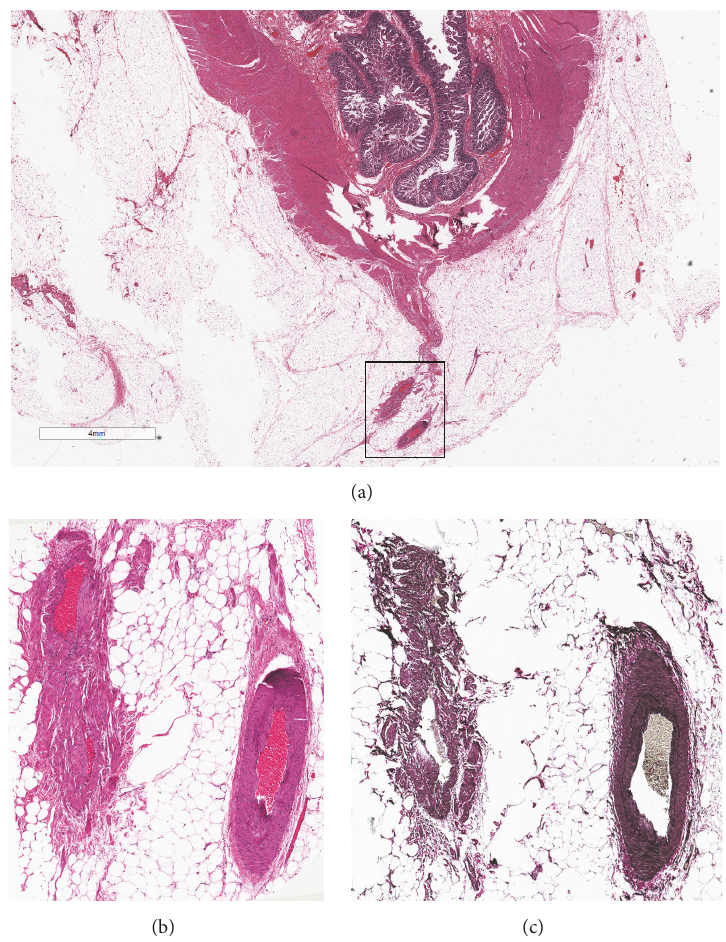
Figure 2: Involvement of the neoterminal ileum by idiopathic myointimal hyperplasia of the mesenteric veins. A representative low- magnification view of the ileum revealed an unremarkable mucosa and ileal wall (a). On high magnification, the peri-ileal veins demonstrated myointimal hyperplasia (b) as evidenced by elastin staining